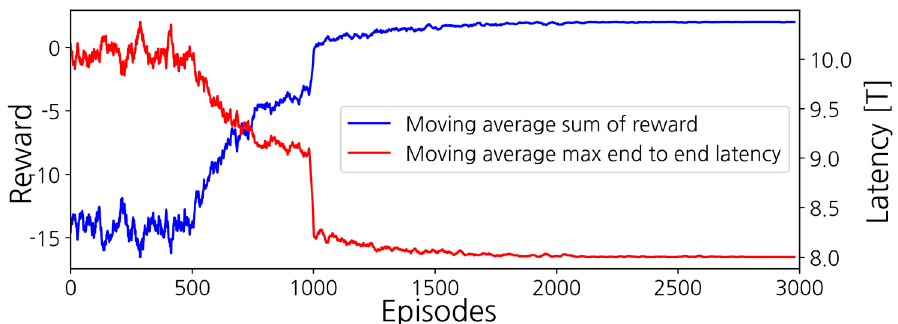
Figure 14. Training result of RL model in topology 3.